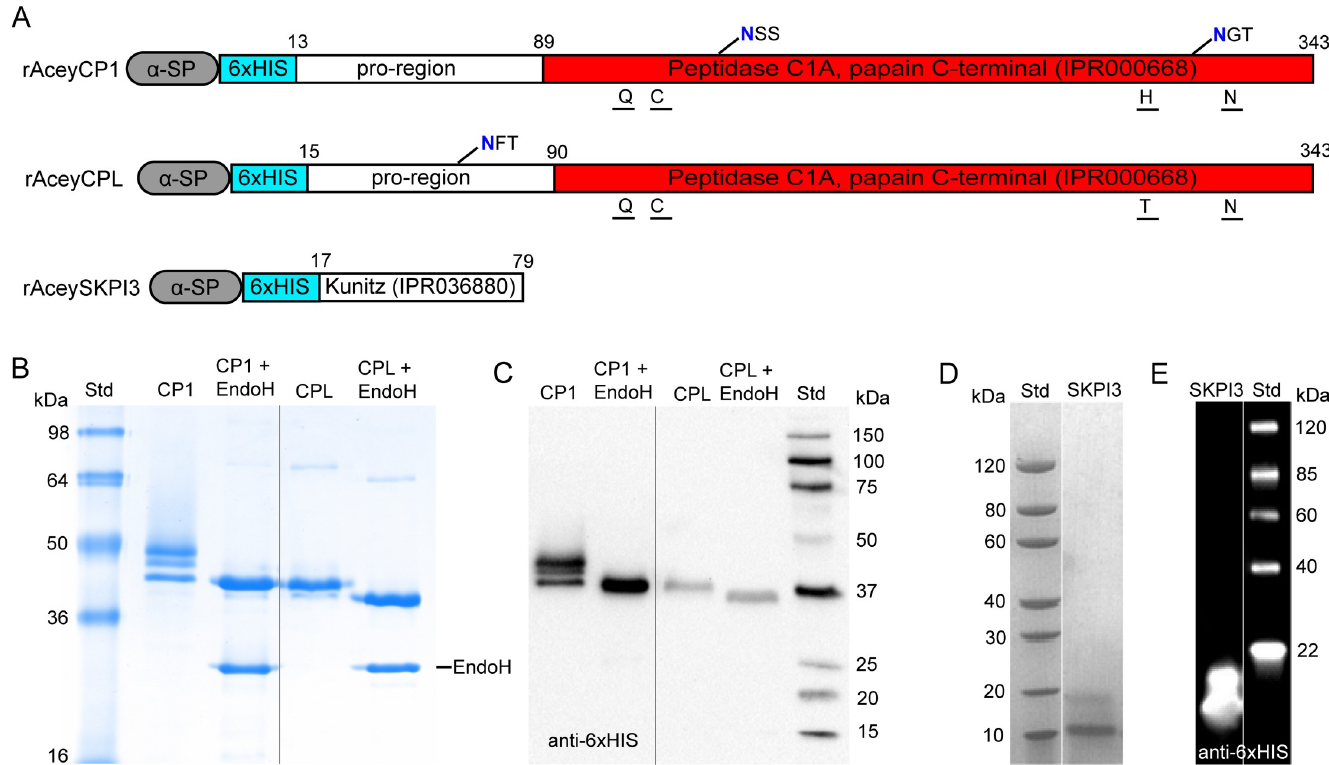
Fig 1. Production of secreted rAceyCP1, rAceyCPL and rAceySKPI3 from Pichia pastoris . (A) Schematic diagrams of rAceyCP1, rAceyCPL and rAceySKPI3. Amino acid positions are indicated above. Putative active site residues are indicated below. N-glycosylation sites are indicated above at their approximate locations with the glycosylated asparagine colored blue. AceyCPL and AceyCP1 share 54% amino acid identity. (B) SDS-PAGE of untreated and endoglycosidase (Endo) H- treated rAceyCP1 and rAceyCPL (Coomassie Blue image). (C) Western blot of untreated and Endo H-treated rAceyCP1 and rAceyCPL (grayscale image). (D) SDS-PAGE analysis of rAceySKPI3 (grayscale image). (E) Western blot of rAceySKPI3 (inverted grayscale image). https://doi.org/10.1371/journal.pntd.0007345.g001 and rAceyCPL with endoglycosidase (Endo) H resulted in shifts to a single ~42-kDa band for rAceyCP1 and a single ~40-kDa band for rAceyCPL (Fig 1B and 1C). According to these results, rAceyCP1 consists of unglycosylated, monoglycosylated, and biglycosylated forms, while rAceyCPL consists of unglycoslyated and monoglycosylated forms. The weak ~19-kDa upper band in rAceySKPI3 could be a form of dimer or a monomer with other post-